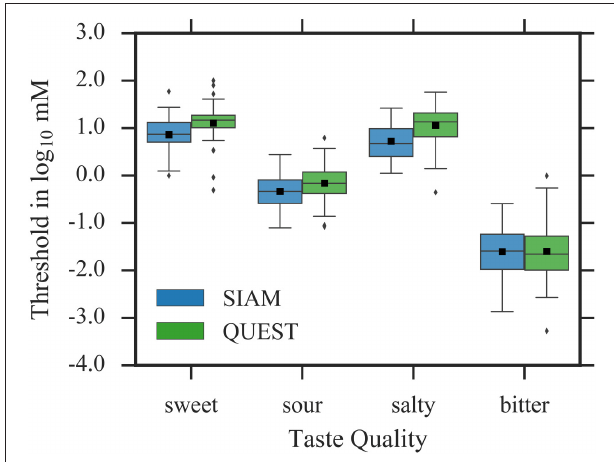
FIGURE 3 | Threshold estimates, averaged across test and retest. Whiskers are 1.5 × interquartile range. Outliers are depicted as diamonds, and sample means as black squares.